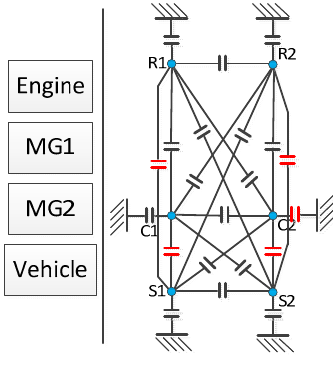
Figure 1. Powertrain components of power-split hybrid electric vehicle (HEV) and all possible clutch locations for a double planetary gear (PG) hybrid.